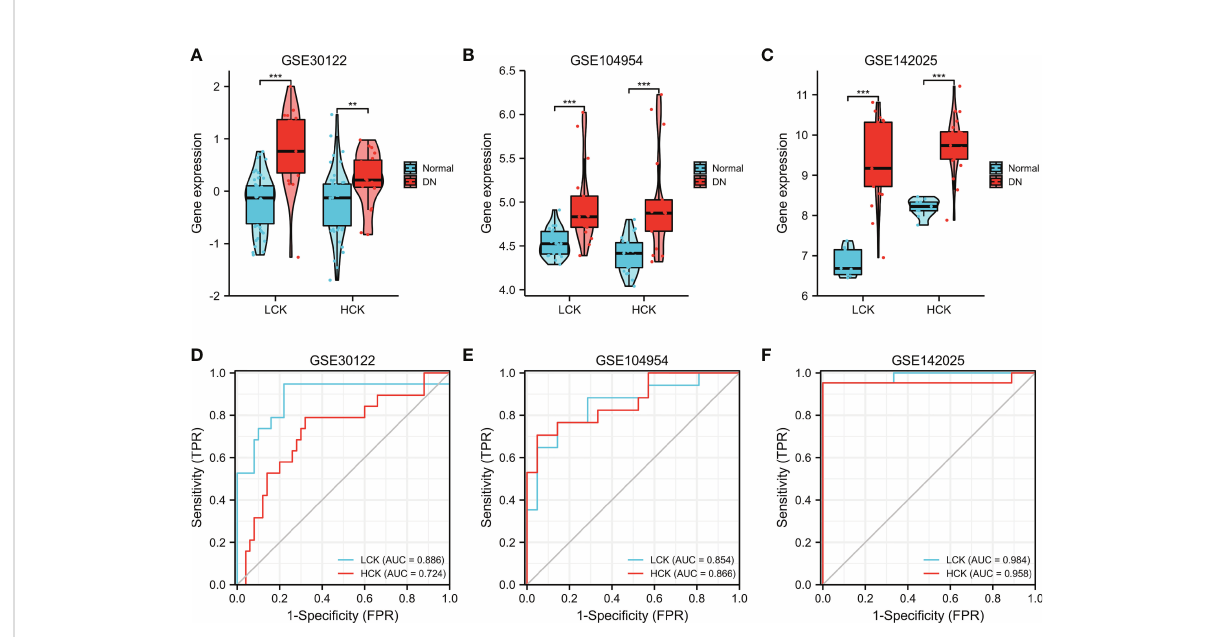
FIGURE 9 Validation of core genes in DN. Veri fi cation of LCK and HCK gene expression in the GSE30122 (A) , GSE104954 (B) , and GSE142025 datasets (C) . **p < 0.01 and ***p < 0.001 were analyzed by the Willcoxon rank sum test. ROC curves of LCK and HCK genes in the GSE30122 (D) , GSE104954 (E) , and GSE142025 datasets (F)